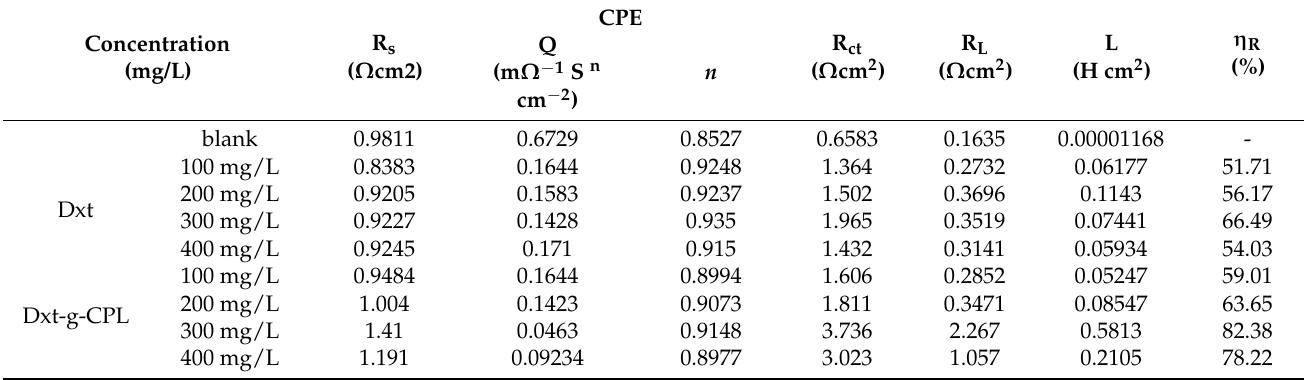
Figure 7. Nyquist and Bode diagrams of J55 steel in 1 M HCl solution with different concentrations of ( A , C , E ) Dxt; ( B , D , F ) Dxt-g-CPL. Table 1. Nyquist diagram-related parameters of J55 steel in 1 M HCl solution with different concentrations of Dxt and